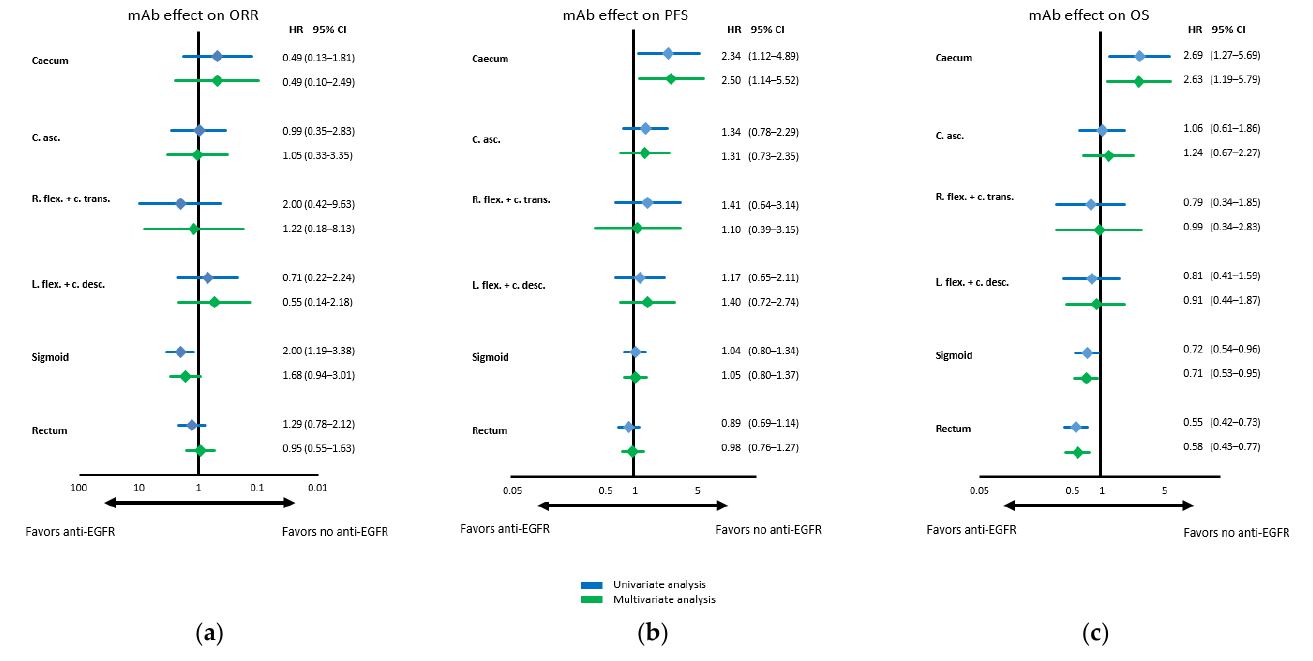
Figure 3. Forest plots of estimated anti-EGFR effect. ( a ) Forest plots of estimated anti-EGFR effect on objective response rate according to exact primary tumor location in RAS/BRAF wild-type tumors. ( b ) Forest plots of estimated anti-EGFR effect on progression-free survival according to exact primary tumor location in RAS/BRAF wild-type tumors. ( c ) Forest plots of estimated anti-EGFR effect on overall survival according to exact primary tumor location in RAS/BRAF wild-type tumors. Legend: Uni- and multivariate analyses of anti-EGFR effect. Results of univariate analysis are depicted as blue bar/diamonds and results of multivariate analysis as green bar/diamonds. Multivariate analyses of progression-free survival and overall survival included study, sex, age, ECOG performance status, liver-limited disease, peritoneal metastasis and prior adjuvant chemotherapy as factors. Multivariate analyses of objective response rate included sex, age, ECOG performance status, liver-limited disease, peritoneal metastasis and prior adjuvant chemotherapy as factors. 95% CI = 95% confidence interval; c. asc. = ascending colon; c. desc. = descending colon; c. trans.= transverse colon; HR = hazard ratio; l. flex. = left flexure; mAb = monoclonal antibody; ORR = objective response rate; OS = overall survival; PFS = progression-free survival; r. flex. = right flexure.